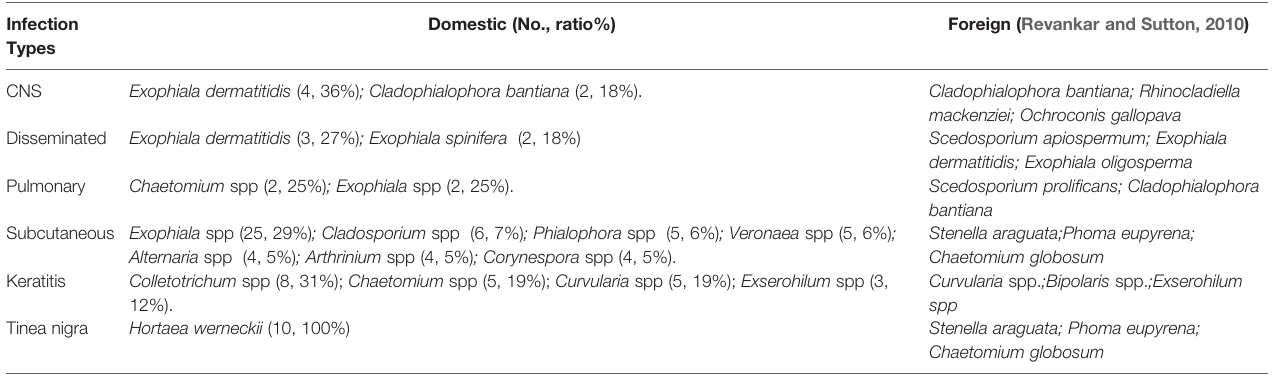
Domestic (No., ratio%)